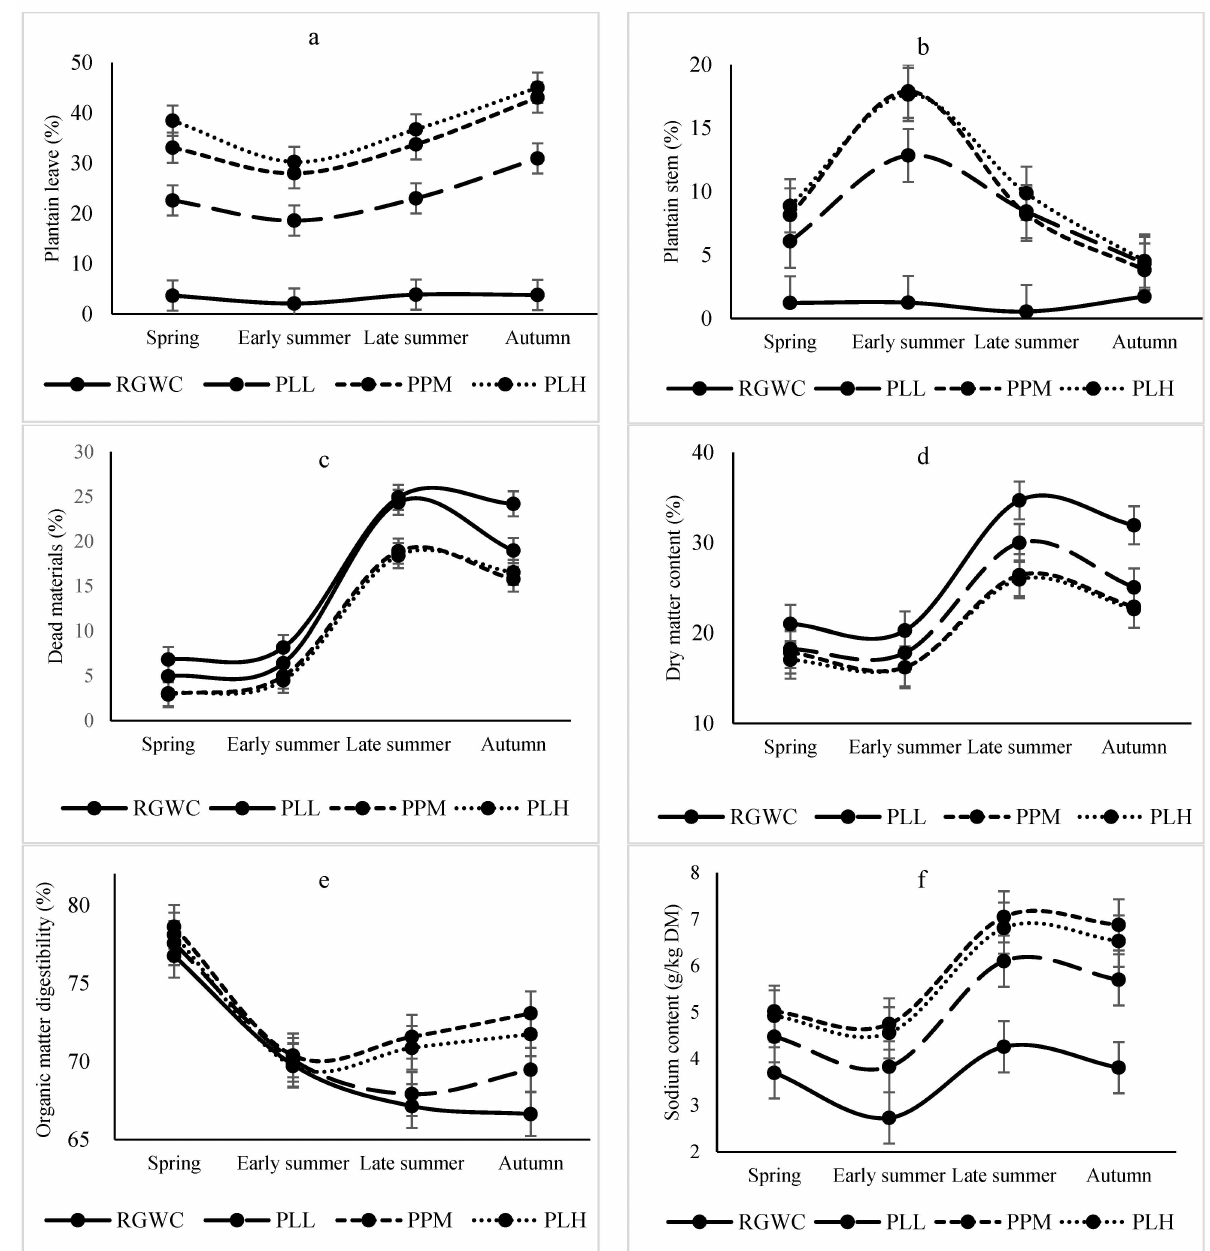
Figure 2. Composition of plantain leaves ( a ), plantain reproductive stem ( b ), dead materials ( c ), dry matter ( d ), organic matter digestibility ( e ), and sodium ( f ) of RGWC, PLL, PLM, and PLH in spring, early summer, late summer, and autumn between September 2019 and March